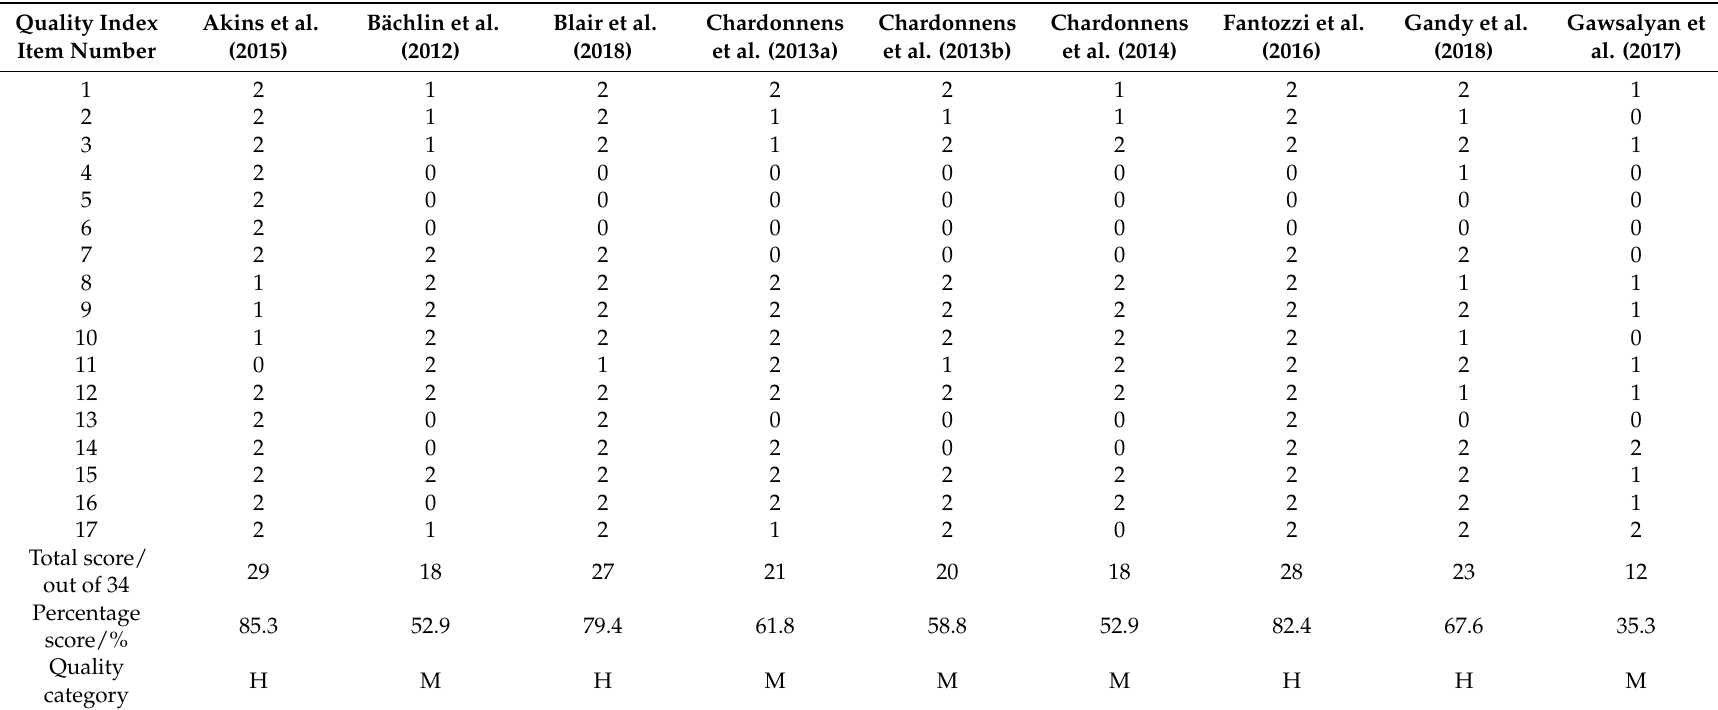
Table A1. Quality assessment of included articles (L: Low, M: Medium, H: